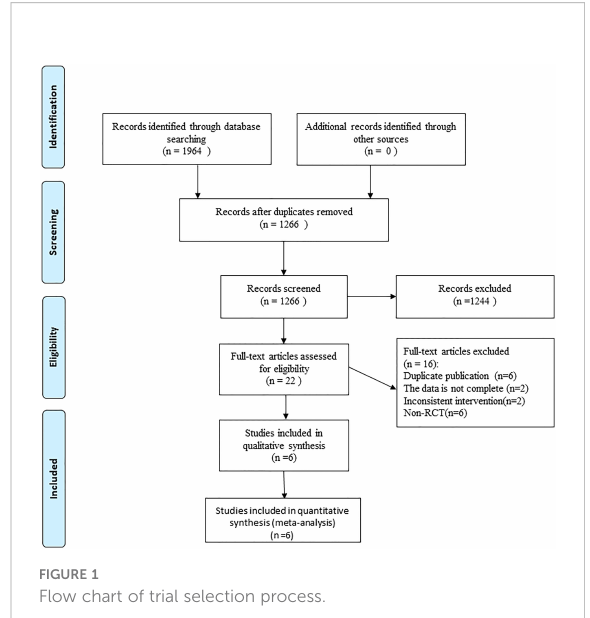
FIGURE 1 Flow chart of trial selection